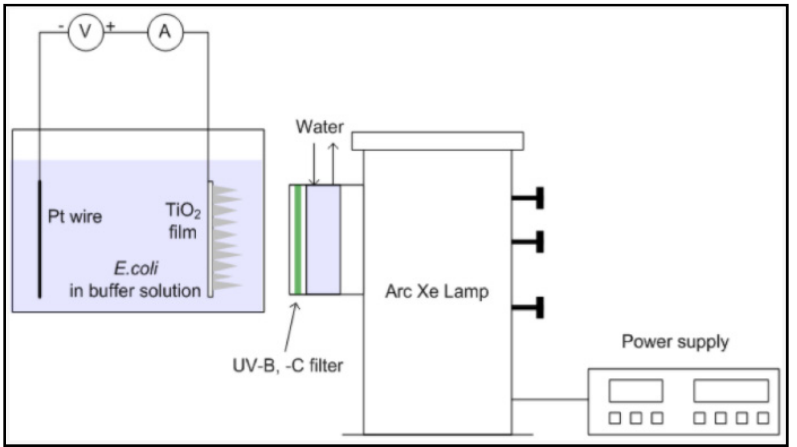
Figure 10. Photoelectrochemical and photocatalytic E. coli inactivation set-up [4]. Open access under creative common agreement (MDPI).